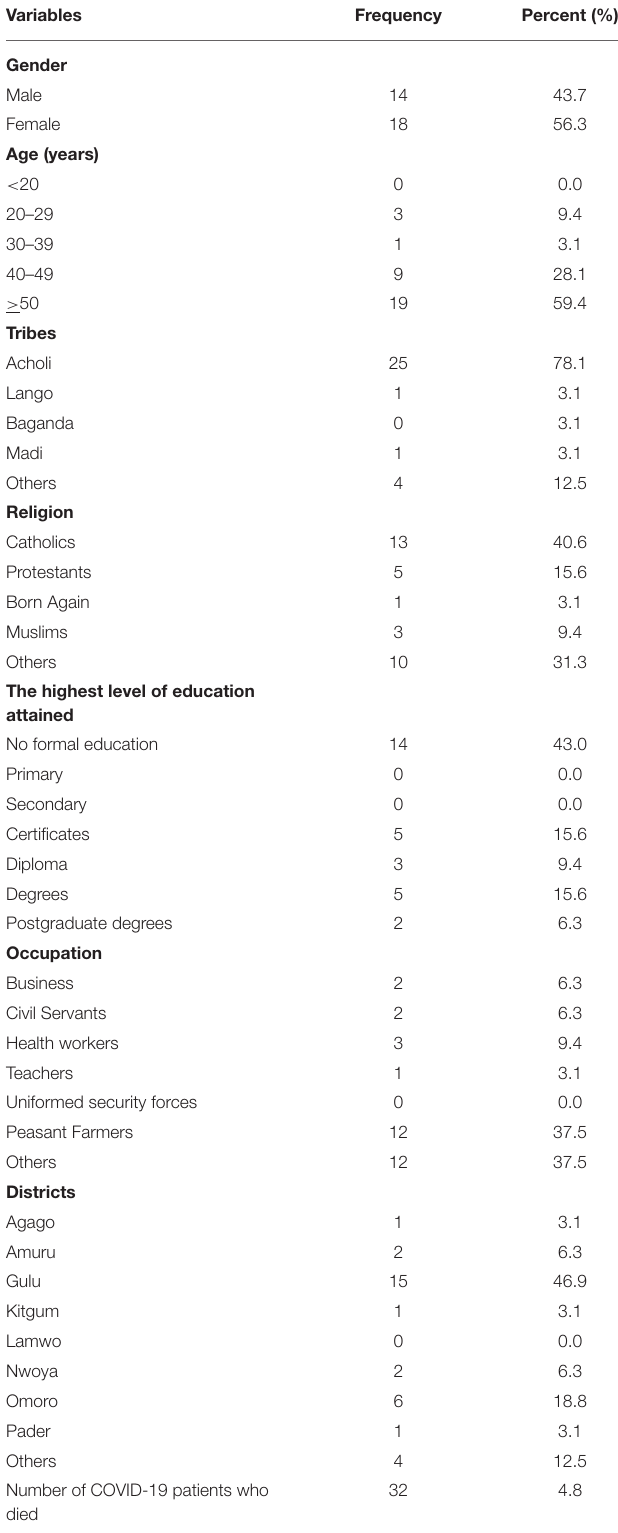
TABLE 1 | Socio-demographic characteristics of the COVID-19 mortality at Gulu Regional Referral Hospital.